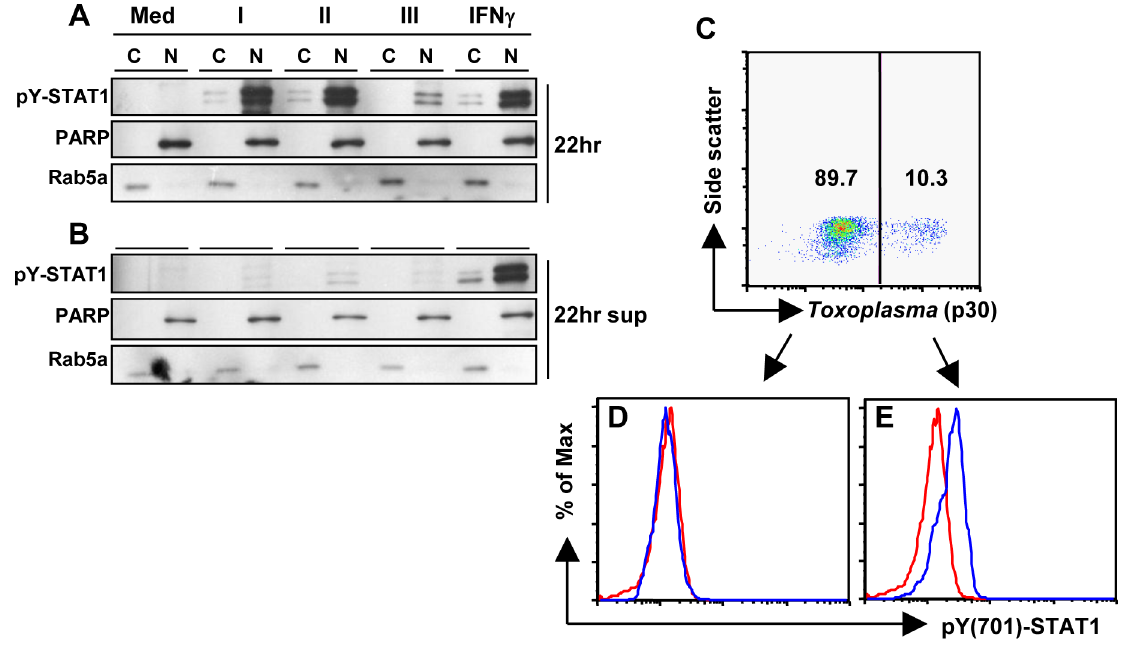
Figure 2. STAT1 phosphorylation is confined to infected cells. (A) BMDC were left in medium alone (Med), infected with type I (RH), type II (PTG) or type III (M774.1) strains of Toxoplasma (3:1 ratio of parasites to cells) or treated with murine IFN c (100 ng/ml). After 22 hours supernatants were collected (22 hr sup), centrifuged and filtered to remove debris and parasites, and subsequently transferred to additional untreated/uninfected BMDC for an additional 20 hours (B). For all samples (A and B), cytoplasmic (C) and nuclear (N) fractions were prepared and subjected to immunoblot analysis with phospho-Tyr701-STAT1 (pY-STAT1). PARP and Rab5a served as cytoplasmic and nuclear loading controls, respectively. (C – E) Cells were infected with the RH strain at a ratio of 0.5 parasites/cell for 20 hours, then subjected to intracellular staining for Toxoplasma (anti-p30/SAG-1) and pY- STAT1 prior to flow cytometric analysis. BMDC were gated on uninfected (D) and infected (E) populations to assess pY-STAT1 expression (blue lines) relative to staining with an isotype control antibody (red lines). All experiments were repeated at least twice with similar